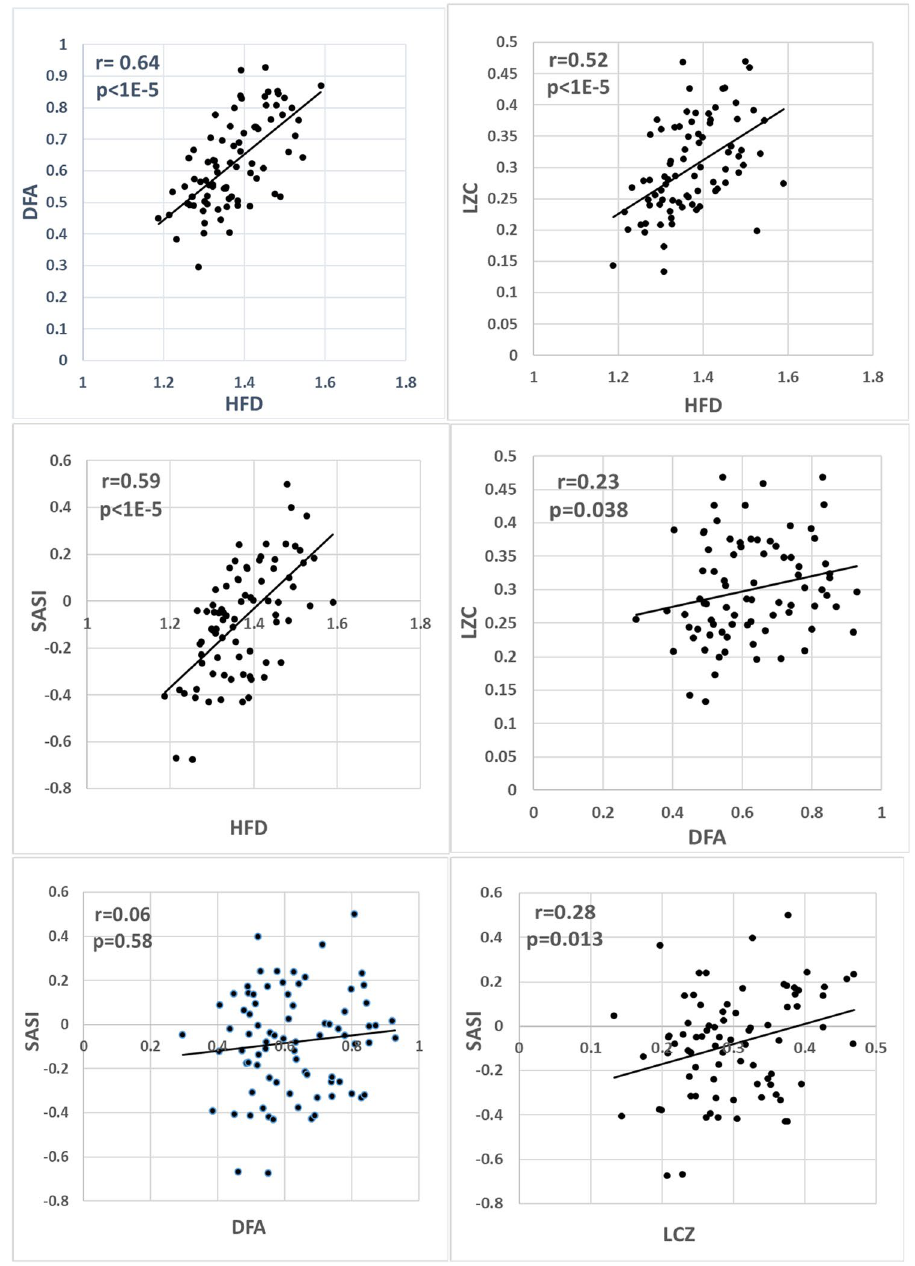
Figure 2. Correlation between various dynamics markers: HFD and DFA, HFD and LZC, HFD and SASI, DFA and LCZ, DFA and SASI, LZC and SASI. The calculated Spearman correlation coefficients r between the markers and corresponding p- values are indicated ( n = 80). The p < 0.00076 (| r |> 0.37) indicates statistical